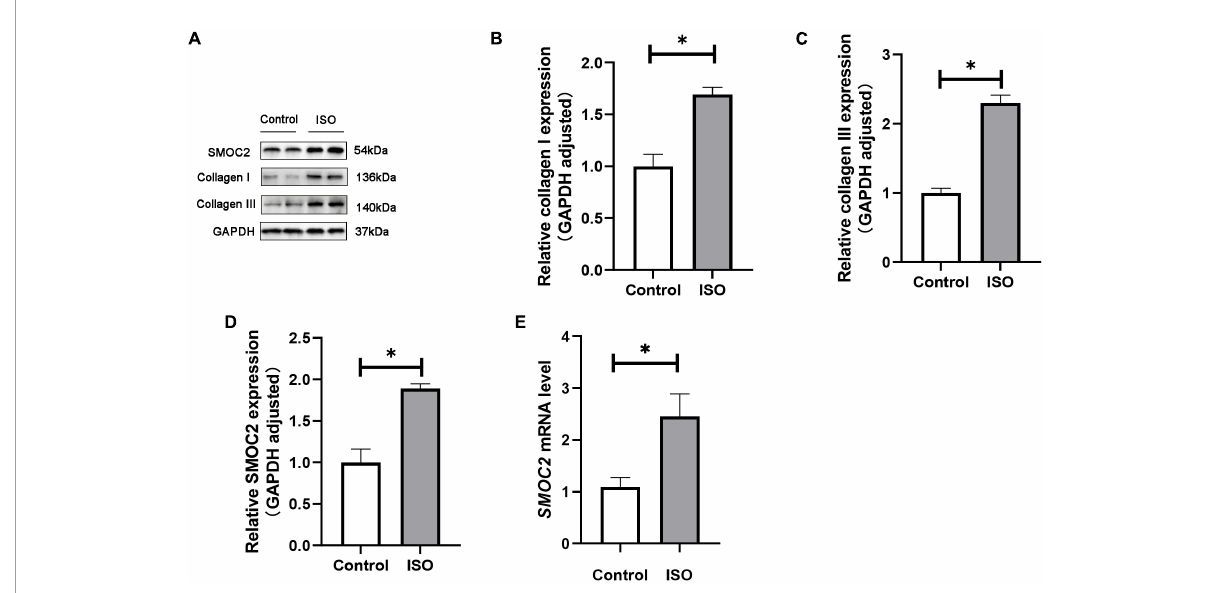
FIGURE1 SMOC2 expression was increased in ISO-induced mice hearts. (A–D) Western blot image and quantitative results of the SMOC2, collagen I, and collagen III in the control group and the ISO group ( n = 6). (E) RT-PCR analysis of SMOC2 mRNA levels in the two groups ( n = 6). ∗ p <